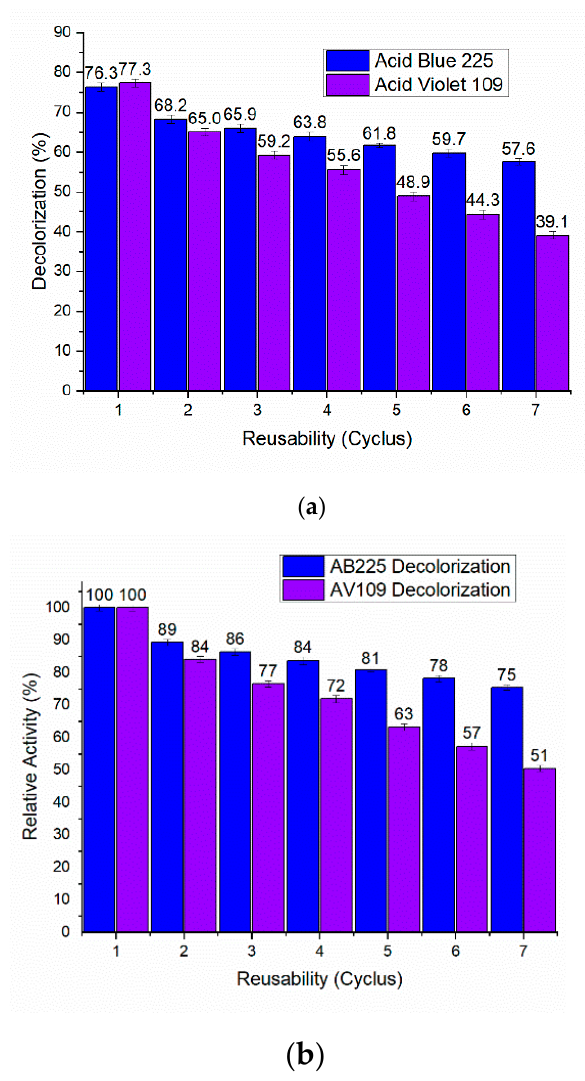
Figure 10. Decolorization of AB225 and AV109 with reusability of HRP-MABs ( a ) decolorization ratio and ( b ) relative activity trough 7 cycles.